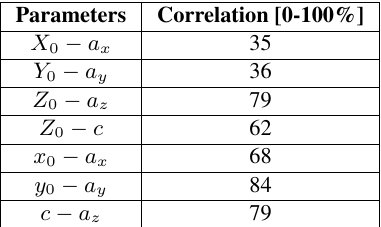
Table 4. Significant correlations of a randomly selected image